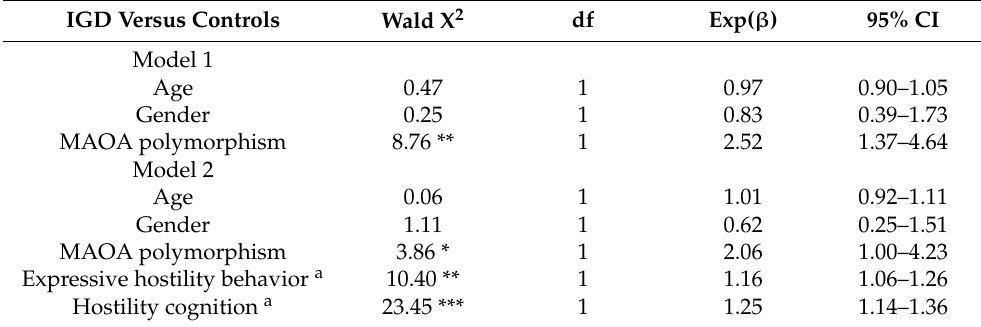
Table 3. Hierarchical logistic regression evaluated the association between IGD and the MAOA polymorphism after controlling for expressive hostility behavior and hostility cognition. IGD Versus Controls Wald X 2 df Exp( β ) 95% CI Model 1 Age 0.47 1 0.97 0.90–1.05 Gender 0.25 1 0.83 0.39–1.73 MAOA polymorphism 8.76 ** Model